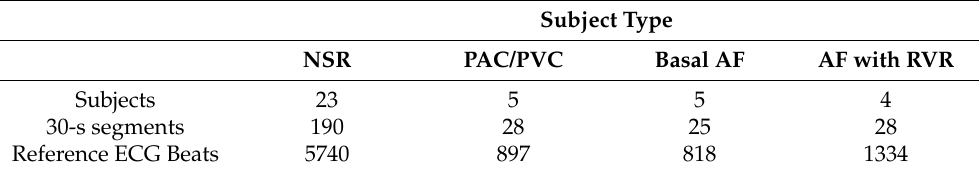
Table 4. Training Dataset Information.